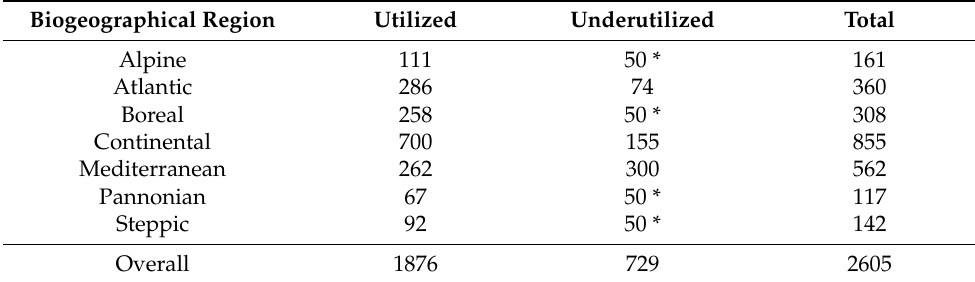
Table 3. Number of validation points per